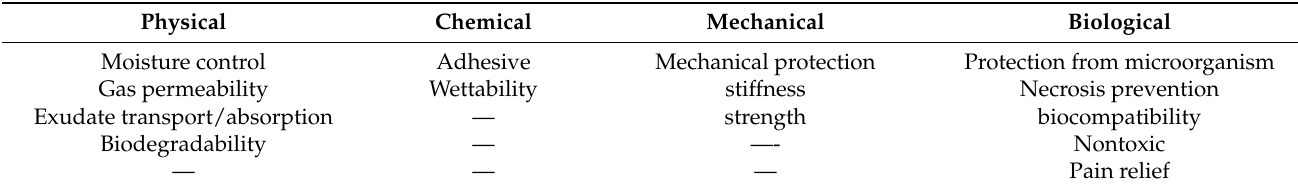
Table 1. Dressing requirements and